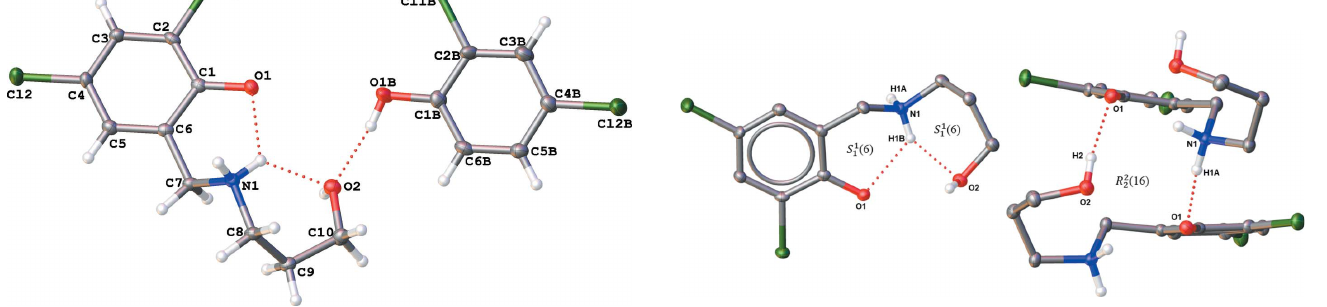
Figure 1 Molecular structure of the title compound showing the numbering scheme and related hydrogen-bonding interactions. Displacement ellipsoids are shown at the 50% probability level and hydrogen bonds are drawn with red dotted